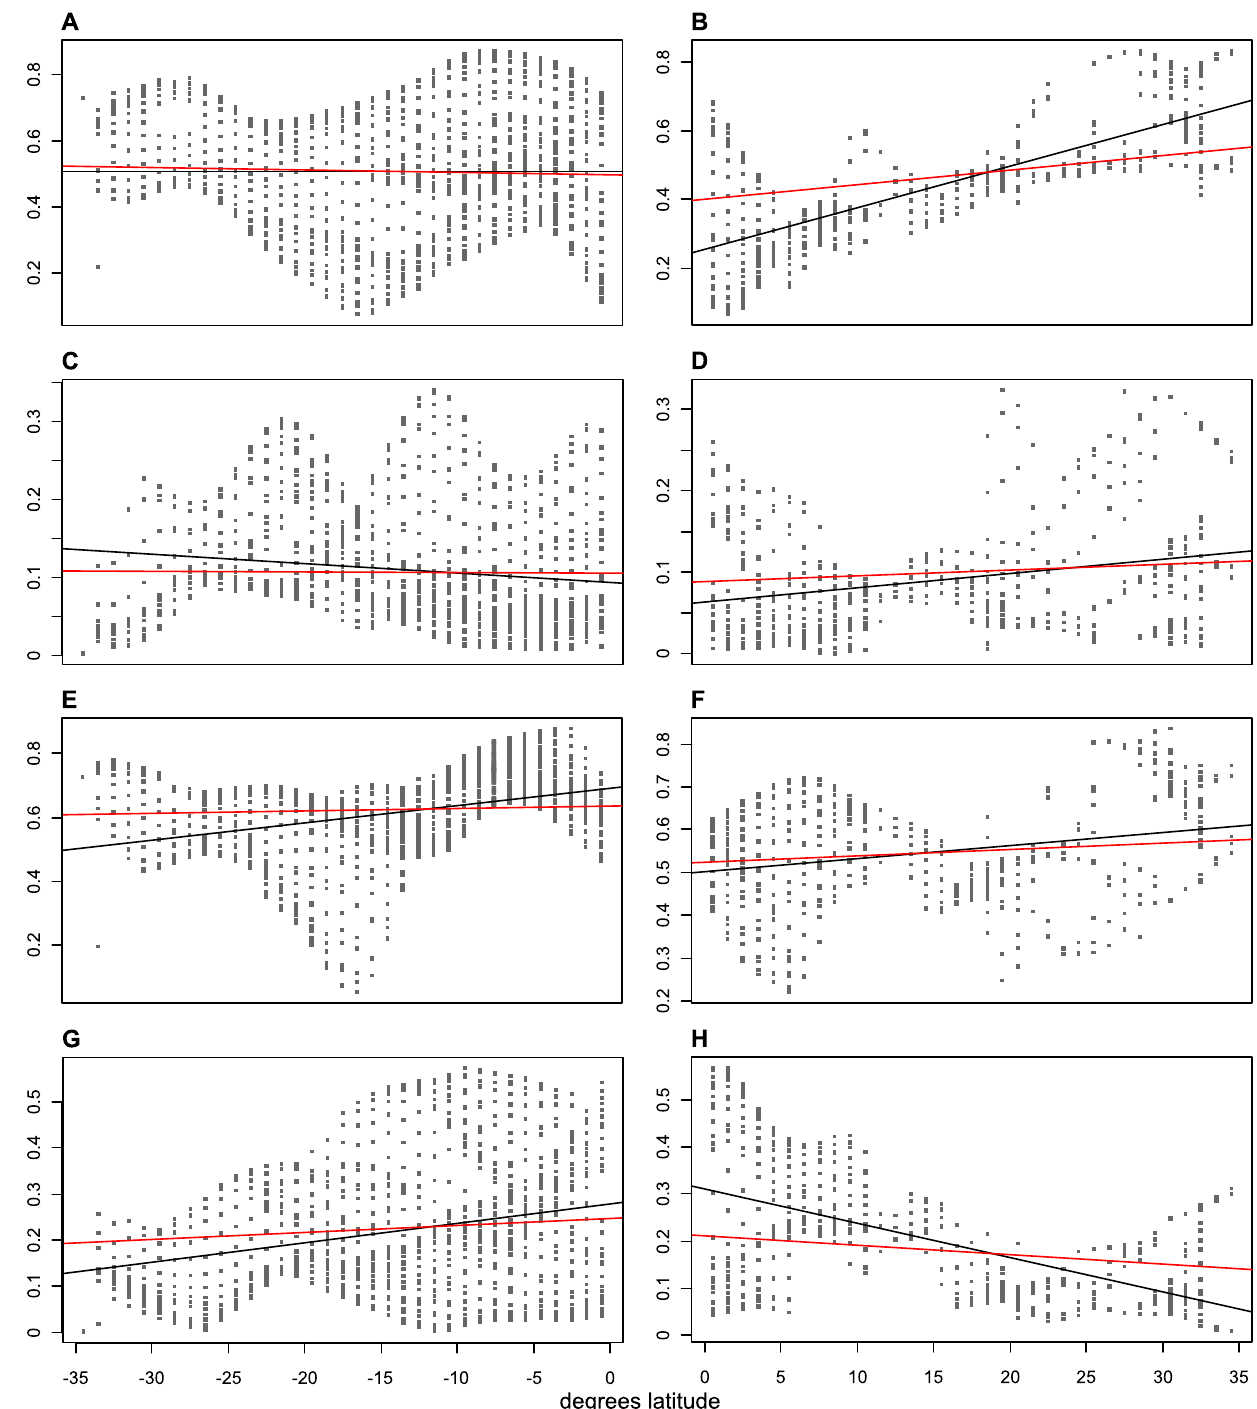
Figure 3. Latitudinal trends in the ability of water and energy to explain American palm species richness. The amount of variation in palm species richness locally explained by energy variables (A–D) and water variables (E–G) plotted against latitude. A, B: total energy (R e ). C, D: pure energy (R pe ). E, F: total water (R w ). G, H: pure water (R pw ). Regression lines obtained from OLS regression (black) and SAR regression (red).